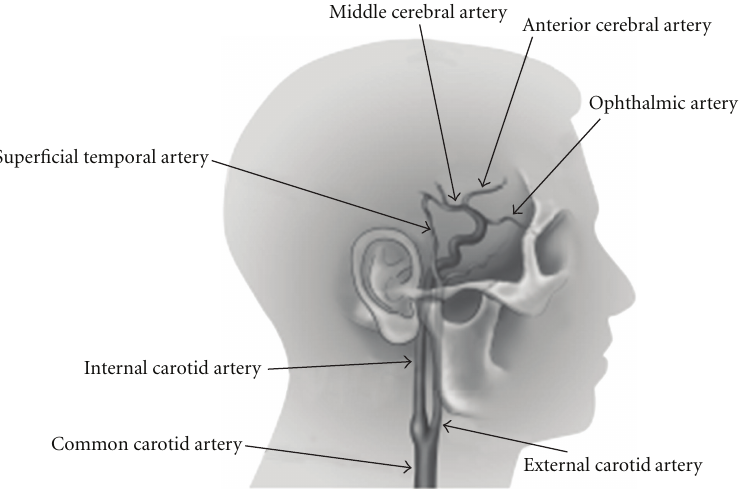
Figure 1: Schematic of STA-MCA bypass.